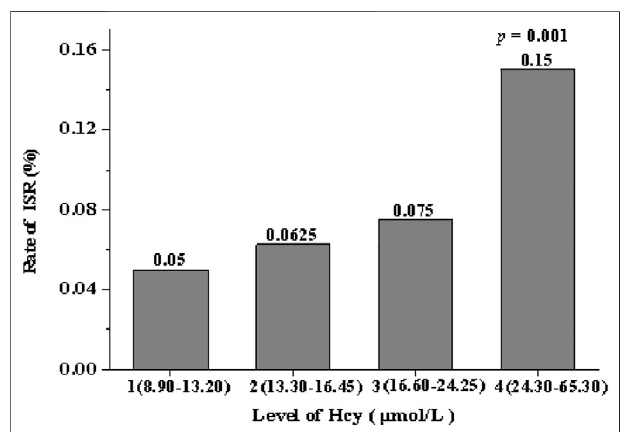
FIGURE 2 | Rate of ISR strati fi ed by quartile of level of